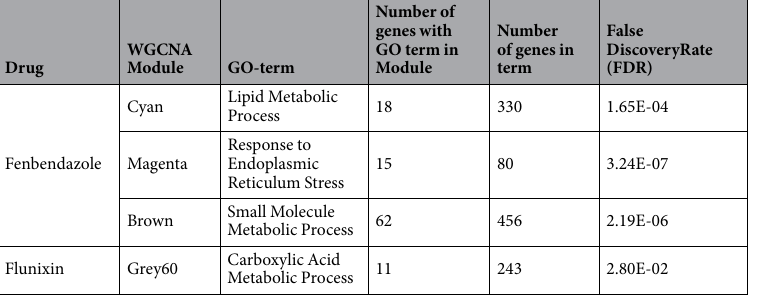
Table 1. Overview of the most significant overrepresented GO terms associated with the modules using